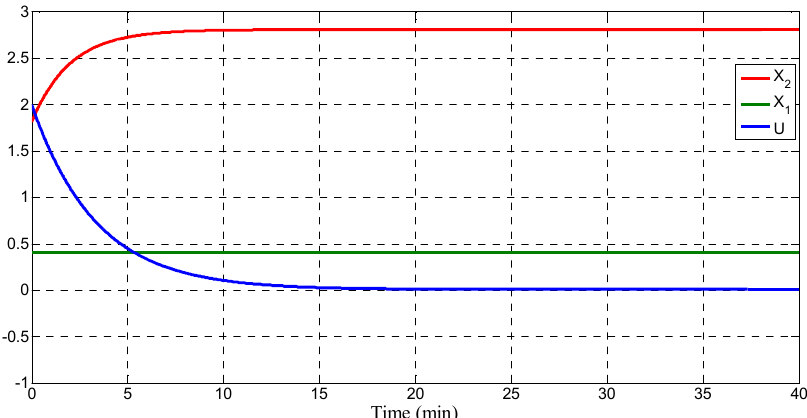
Figure 2. Stabilization and tracking by I/O linearization.